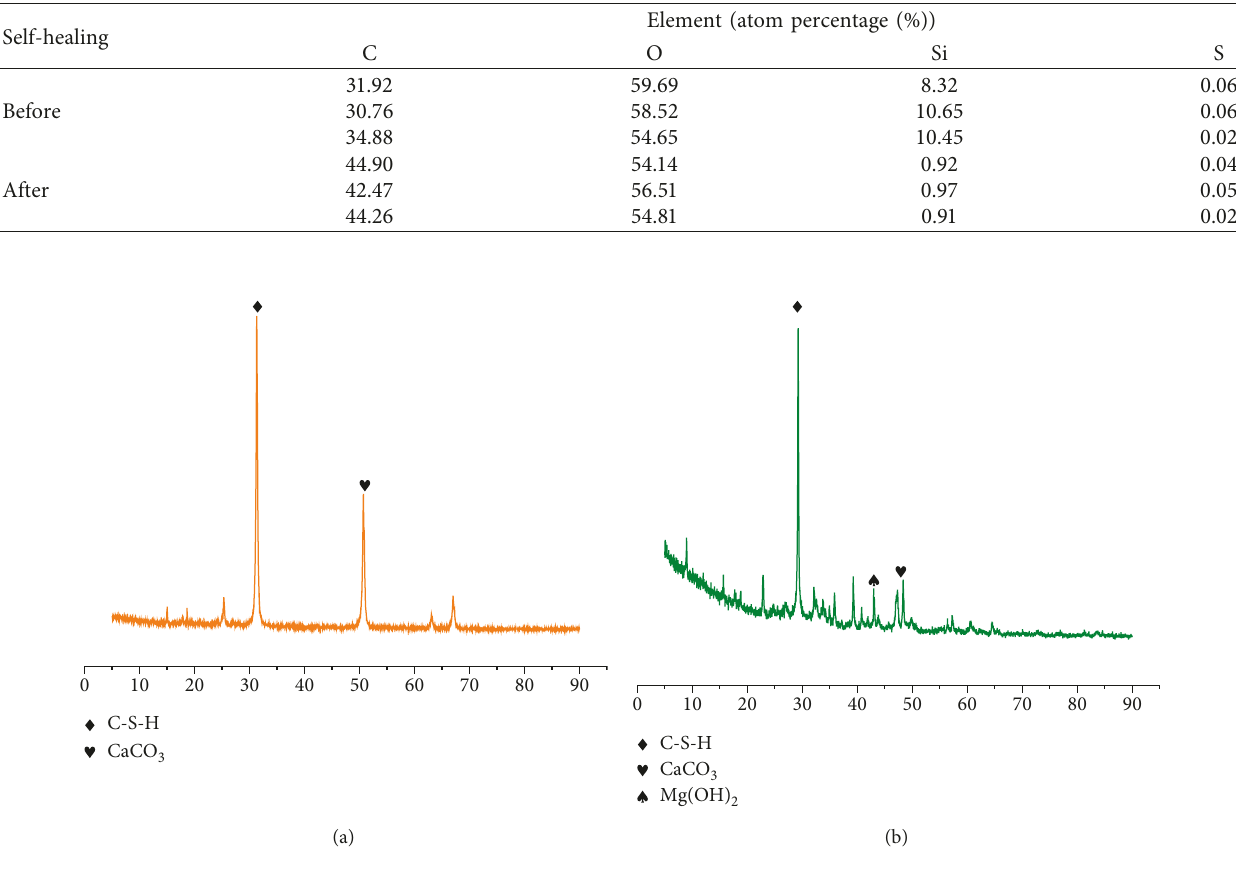
Figure 14: XRD analysis for self-healing products of ECC incorporating MgO and SAP: (a) Major products composed of C-S-H and CaCO (b) major products composed of